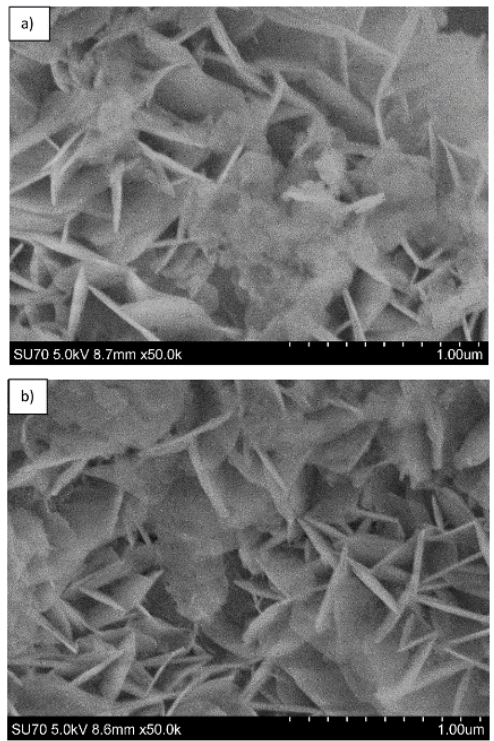
Figure 11. SEM micrographs of Mg 3 /Al 0.99 Eu 0.01 -tartrate ( a ) and Mg 3 /Al 0.99 Eu 0.01 -benzoate ( b ) LDHs.